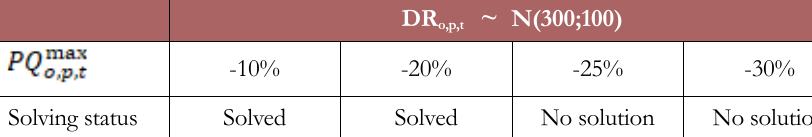
Table 9. Solving status